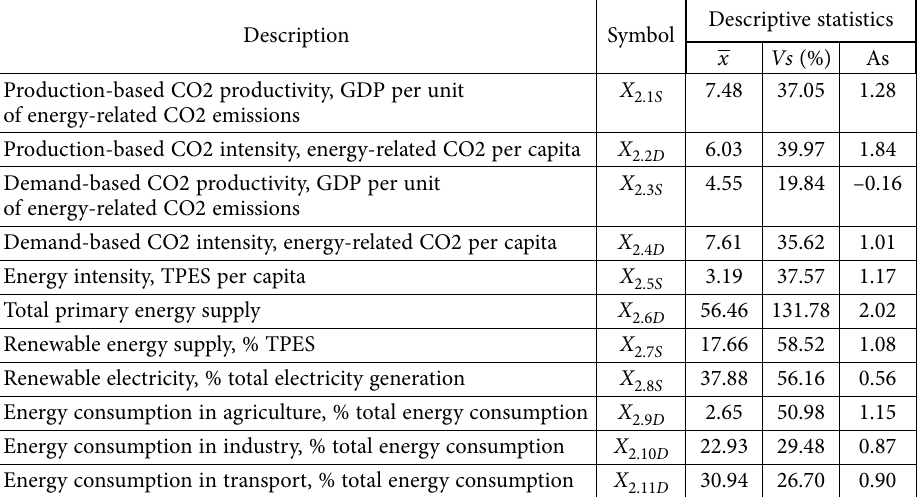
Table 3. Environmental and resource productivity (dimension II) Description